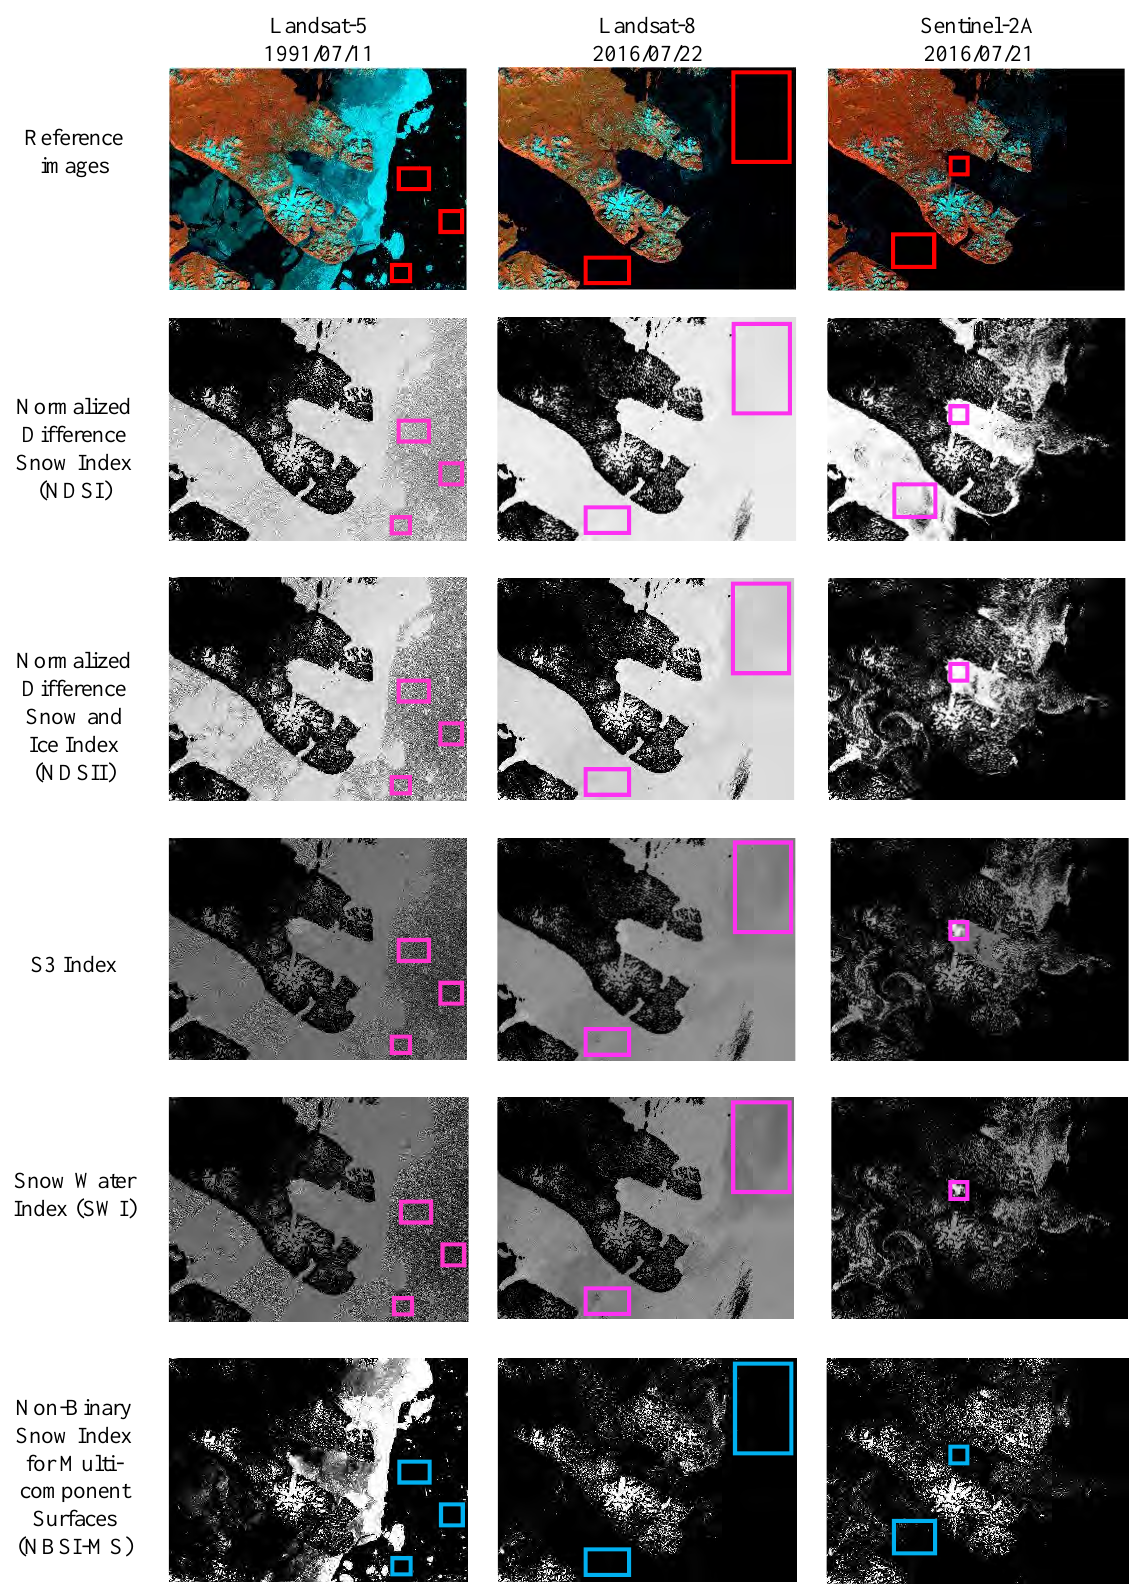
Figure 9. Snow cover extraction maps produced by the Snow-Cover Indices without binarization in the Greenland region recorded by the Landsat and Sentinel-2A satellites on different dates. The reference images are used to visualize the amount of snow cover in blue